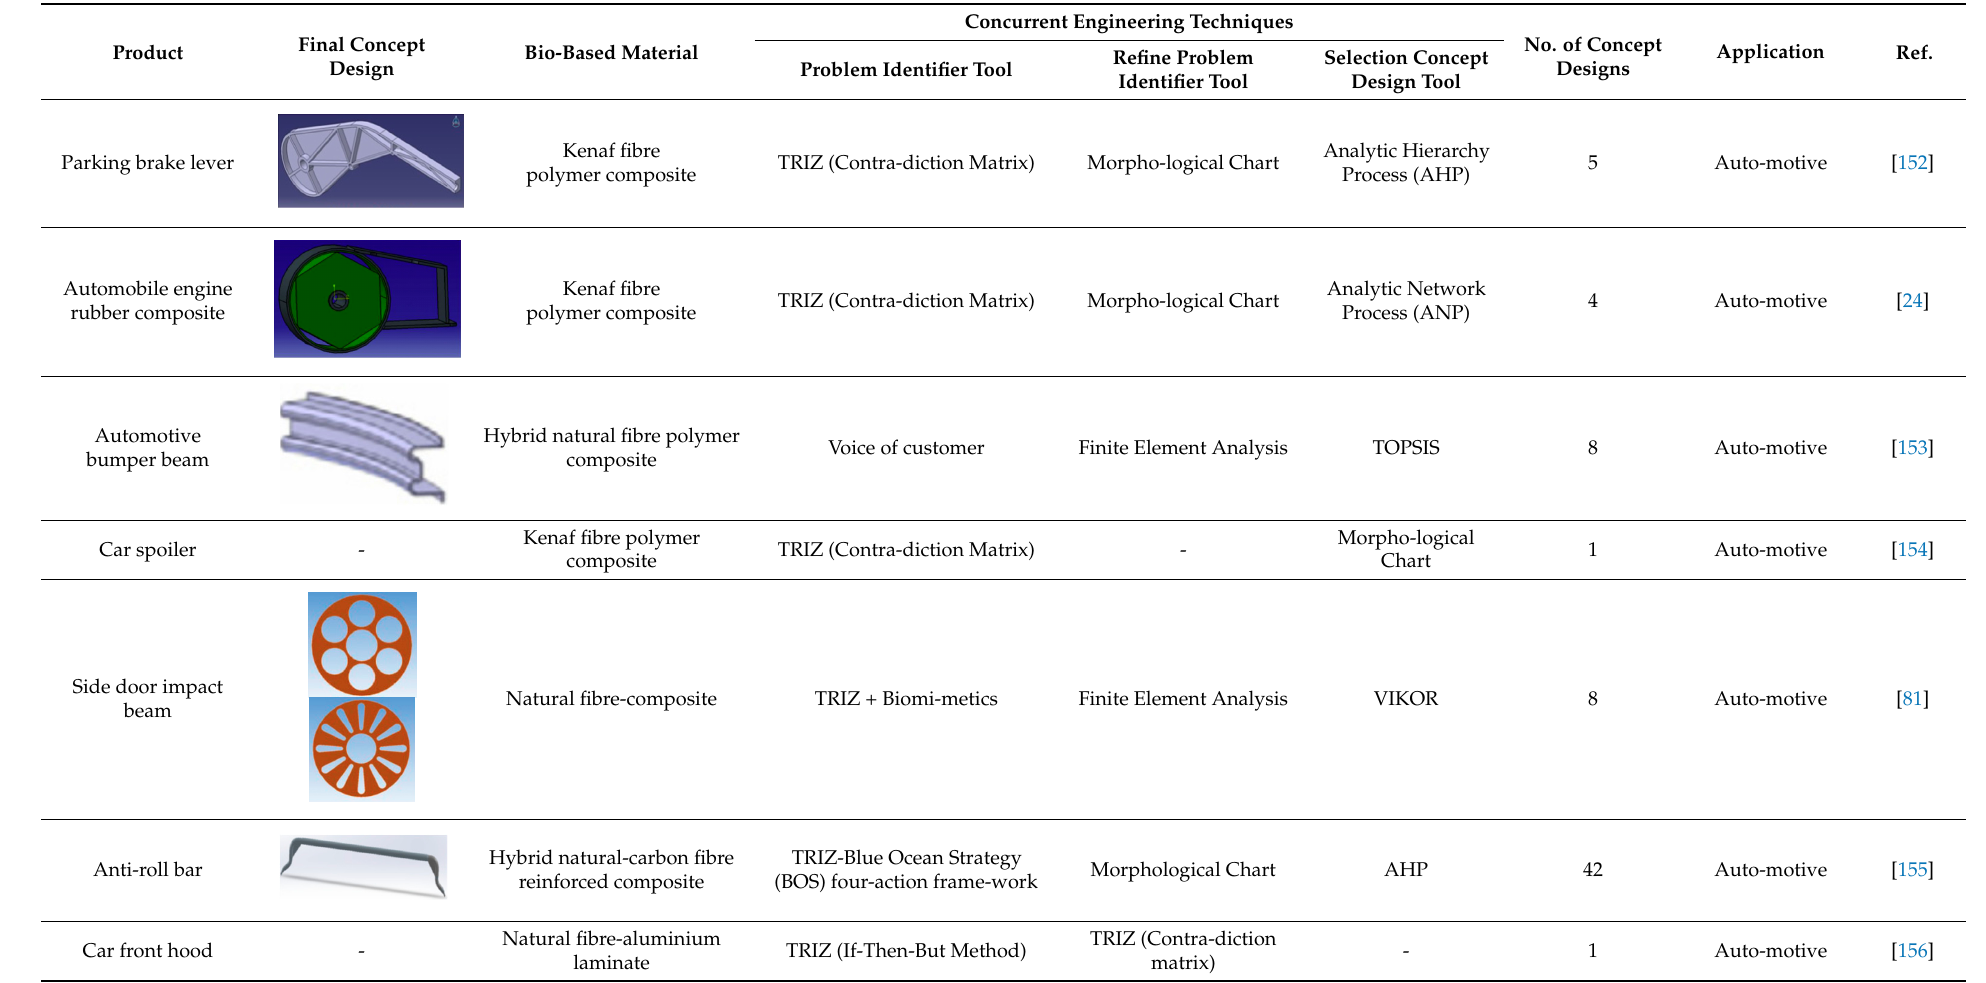
Table 2. Recent developments and advancements of bio-based products using DfS in concurrent engineering approach.